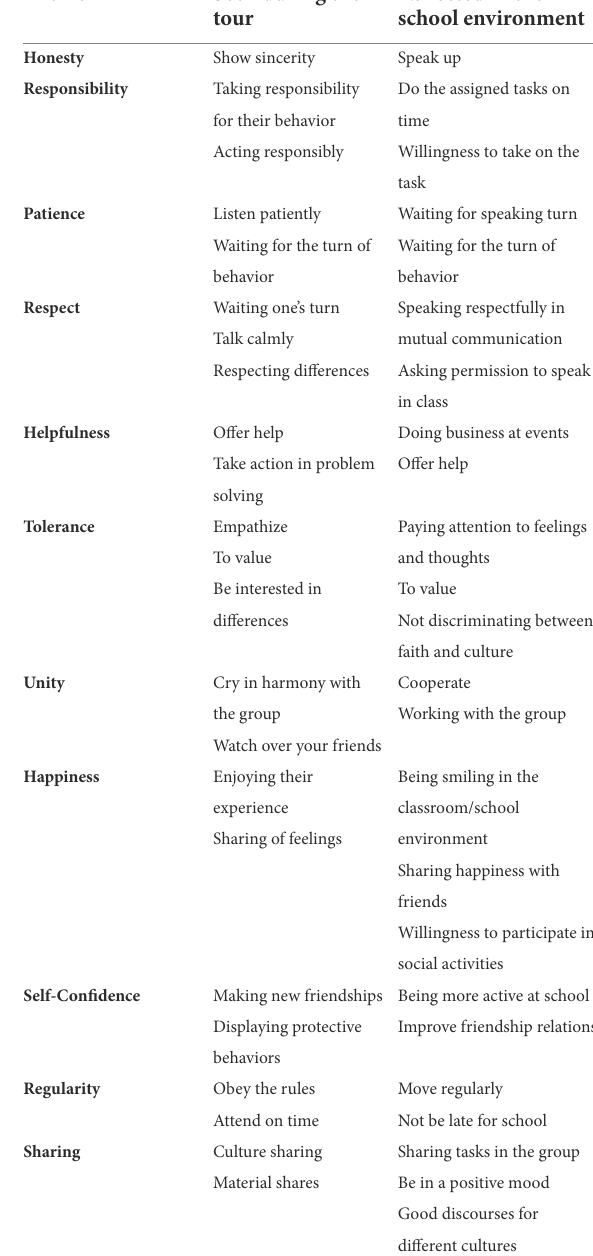
TABLE 3 Comparison of affective behaviors observed during and after sightseeing activities.